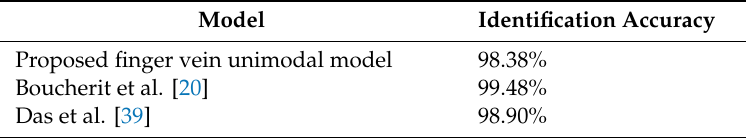
Figure 6. CMC curves for the multimodal models with the score fusion method. Table 3. Comparison between the finger vein unimodal model with previous models.